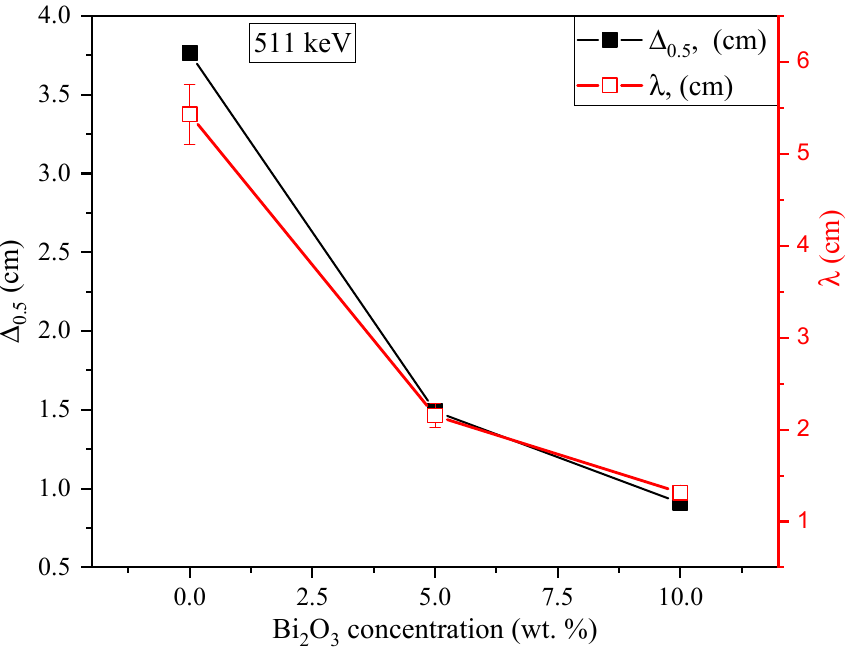
∆ 0.5 and relaxation length (